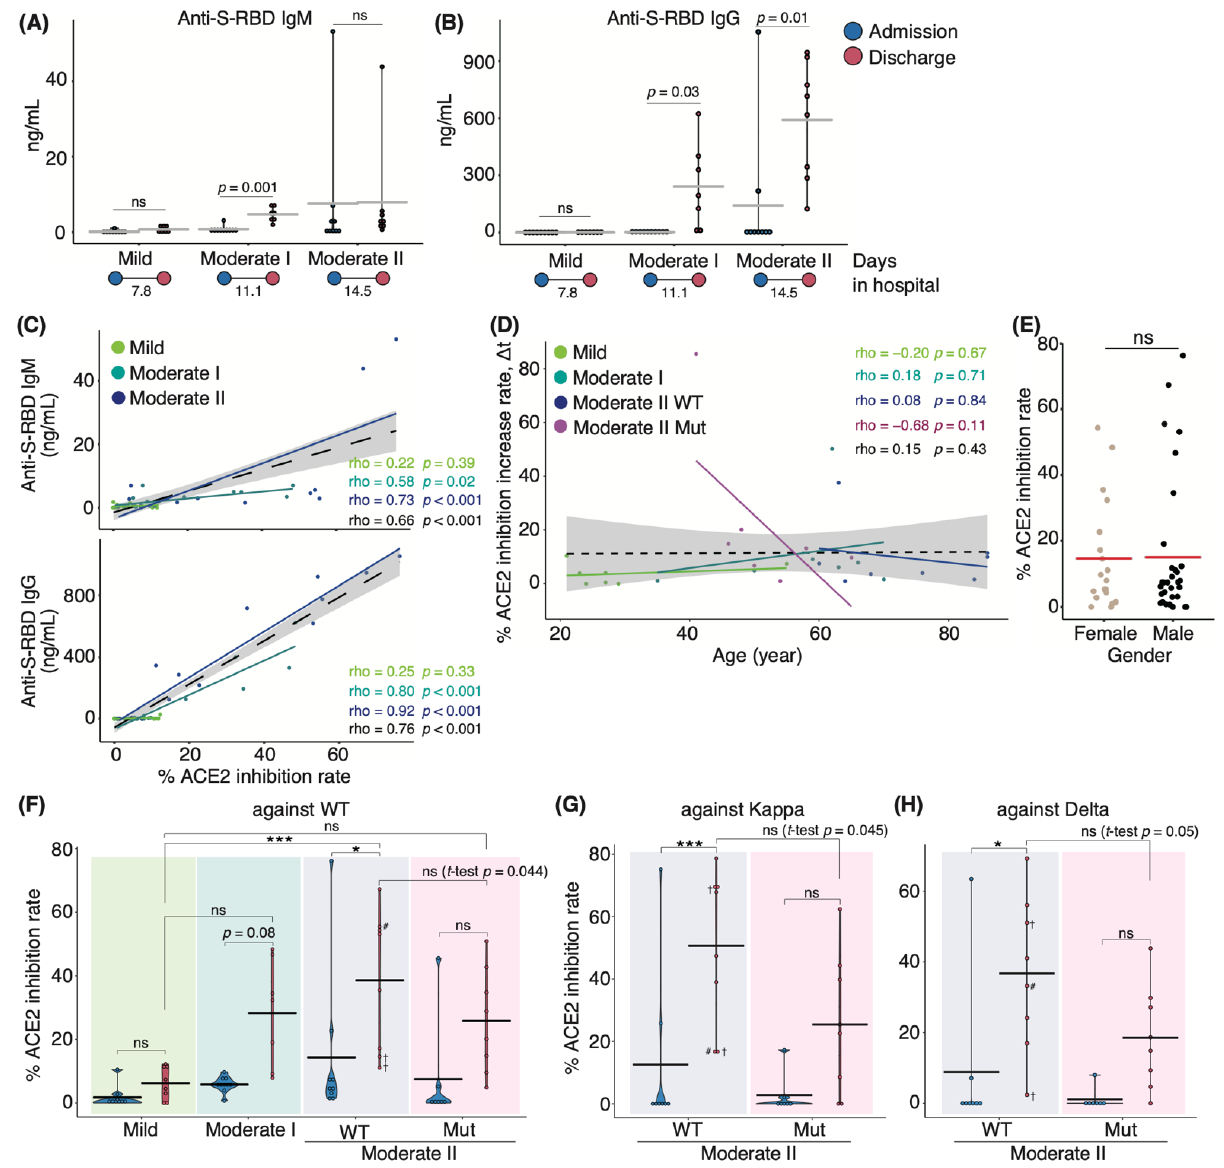
Figure 1. Serum antibody features in COVID-19 patients during hospitalization: Graphs show serum anti-S-RBD IgM ( A ) and IgG ( B ) levels for each disease severity ( n = 9 patients/mild group; 10 patients/moderate I group; 9 patients/moderate II patients). Blue and red dots indicate admission and discharge, respectively; the duration of hospitalization is indicated at the bottom of each panel. Graphs show the correlation between anti-S-RBD IgM or IgG and neutralizing antibody titer ( C ) and age, as well as the change in the titer against the WT strain in patients infected with the WT and VOCs ( D ). Each dot denotes di sease severity, and Spearman’s correlation coefficients are shown within the graph. Gray areas indicate a 95% confidence interval (CI) for the total. ( E ) Dot plot indicates the neutralizing potency against the WT strain by sex. Graphs show the serum- neutralizing antibody titer against WT ( F ), Kappa ( G ), and Delta ( H ) variants at each severity (moderate II is classified by the infected strains, n = 9 patients/mild group; 10 patients/moderate I group; 9 patients/WT-infected moderate II group; 8 patients/VOC-infected moderate II group). Statistical significances were determined using the Tukey – Kramer test and Welch ’ s t -test. All horizontal bars show mean values. Cross, deceased; #, long-term observed healthcare worker. * p < 0.05; *** p < 0.005; ns, not significant.